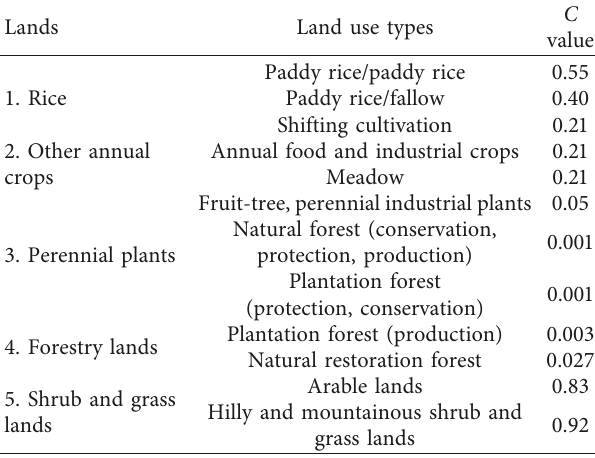
Table 2: The C factor assigned by land use types in the study area. Lands